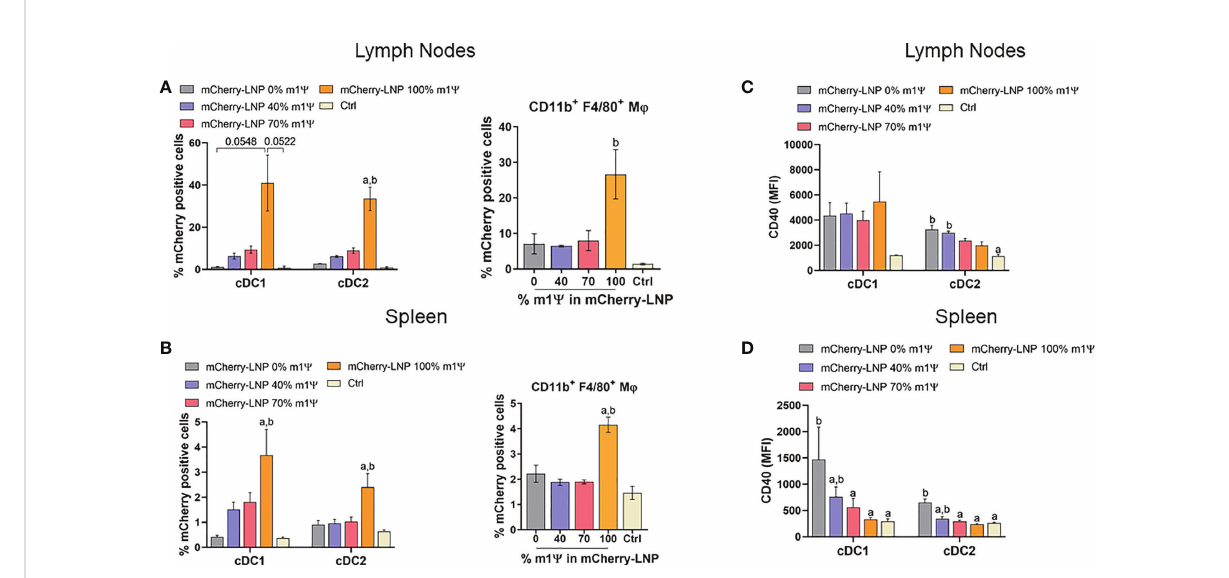
FIGURE 2 mRNA-LNP uptake by APCs in lymph nodes (LNs) and spleens in vivo . Mice were intramuscular injected with 10 µg of mCherry mRNA-LNP with 0, 40, 70, or 100% of m1 Y modi fi cation and the control group received PBS. At 48 hr of mRNA administration, quanti fi cation of mCherry-positive cells in (A) LNs and (B) spleen of conventional type 1 (cDC1) and conventional type 2 (cDC2) dendritic cells (left), and M F (right) were determined. MFI of costimulatory molecule CD40 on cDC1 and cDC2 from (C) LNs and (D) spleen were shown. The results are presented as the mean ± SEM of biologically independent mice ( n = 6) per group. Statistical signi fi cance by one-way ANOVA with Bonferroni multiple comparisons test when p < 0.05 compared to the unmodi fi ed target antigen: a, or control (PBS): (D) cDC1 subset was de fi ned as Dump - (B220 - NK1.1 - CD3 - TER-119 - CD19 - ) CD11c + MHCII + XCR1 + . cDC2 subset was de fi ned as Dump - (B220 - NK1.1 - CD3 - TER-119 - CD19 - ) CD11c + MHCII + CD172a + .